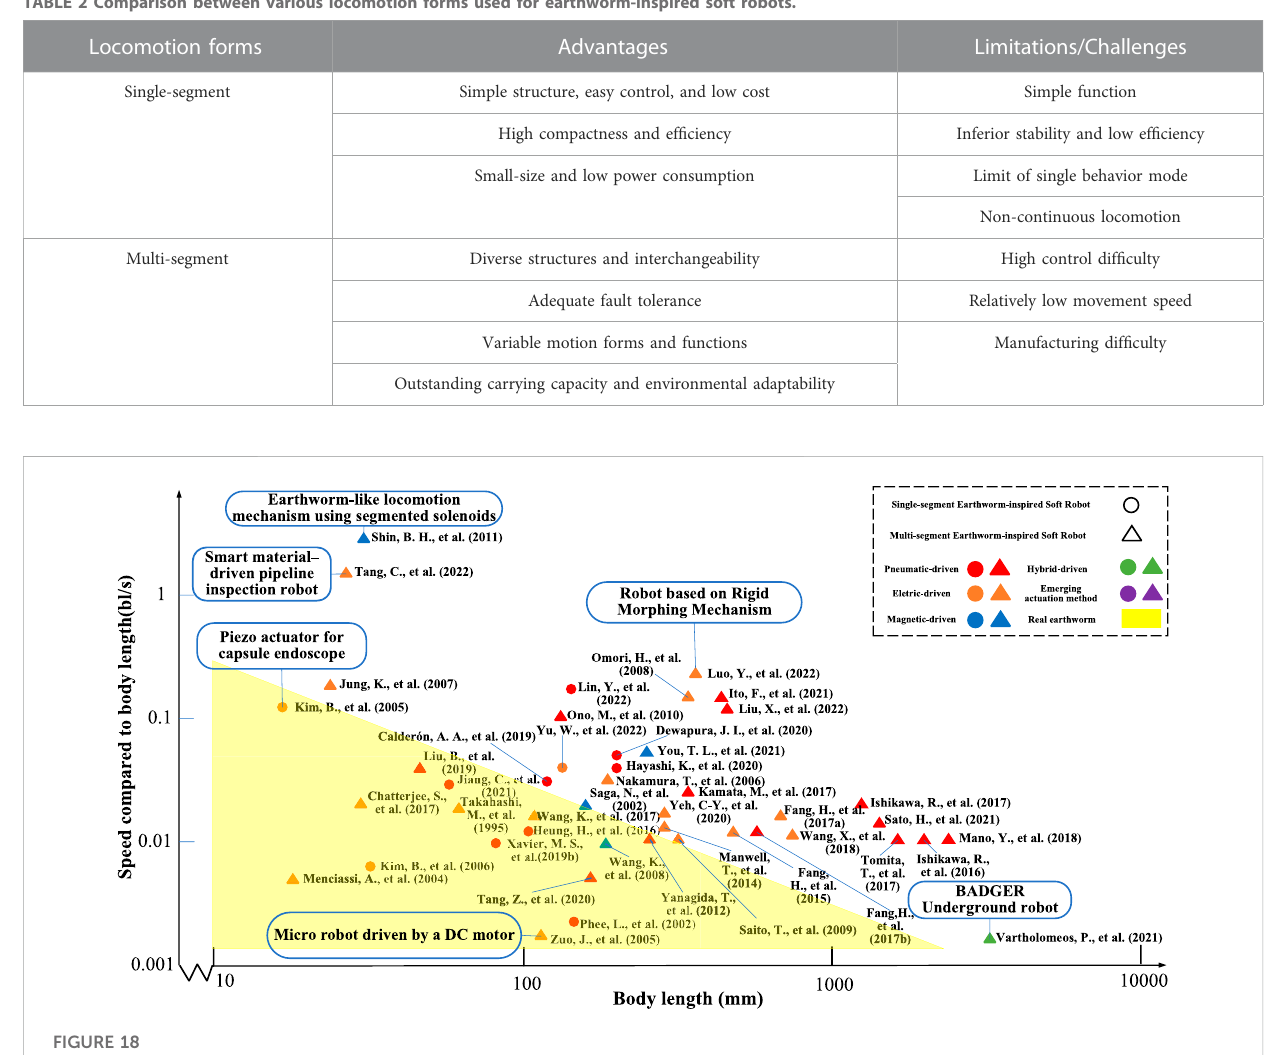
FIGURE 18 Comparison of standardized speed divided by body length of earthworm-inspired soft